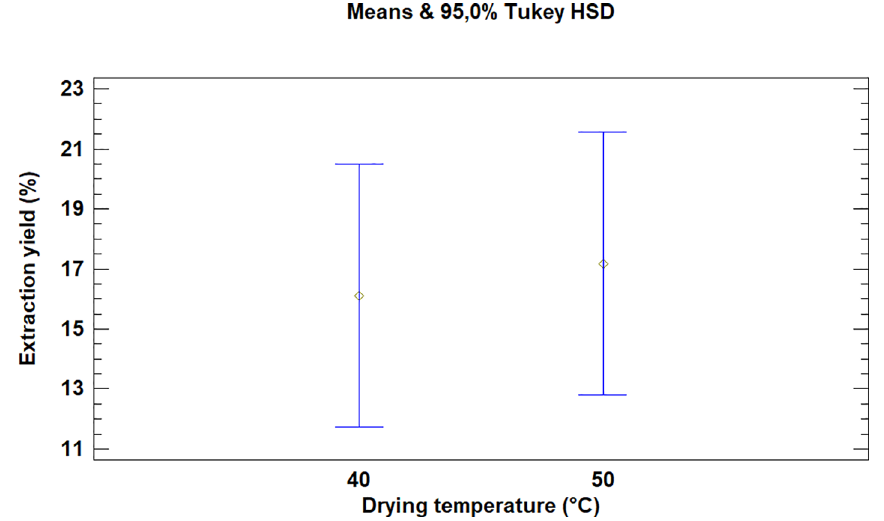
Figure 6. Comparison of Tukey means for yields of Croton floccosus extracts according to drying temperature.